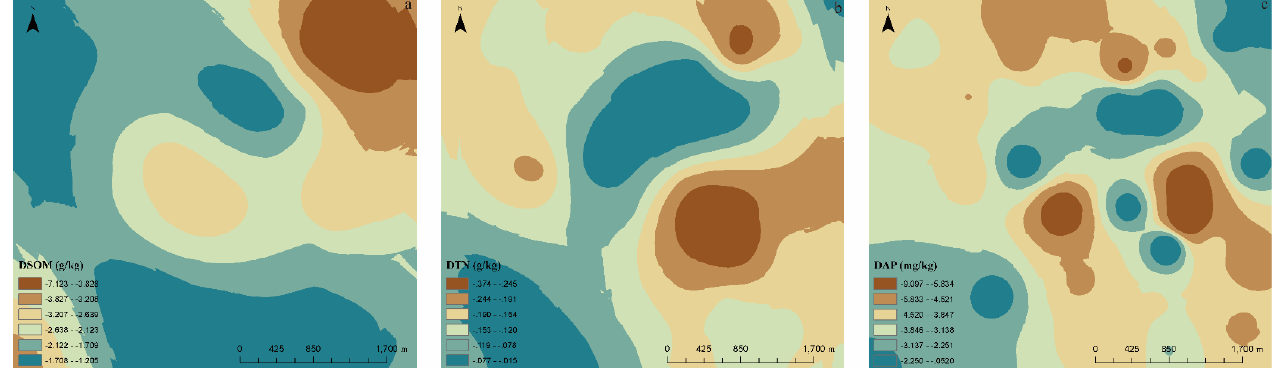
Figure 5. Spatial distribution of DSOM ( a ), DTN ( b ), and DAP ( c ) based on kriging using 20 measured points and 20 unmeasured points predicted by random forest. Table 4. The validation of the Kriging interpolation using 20 and 40 points.